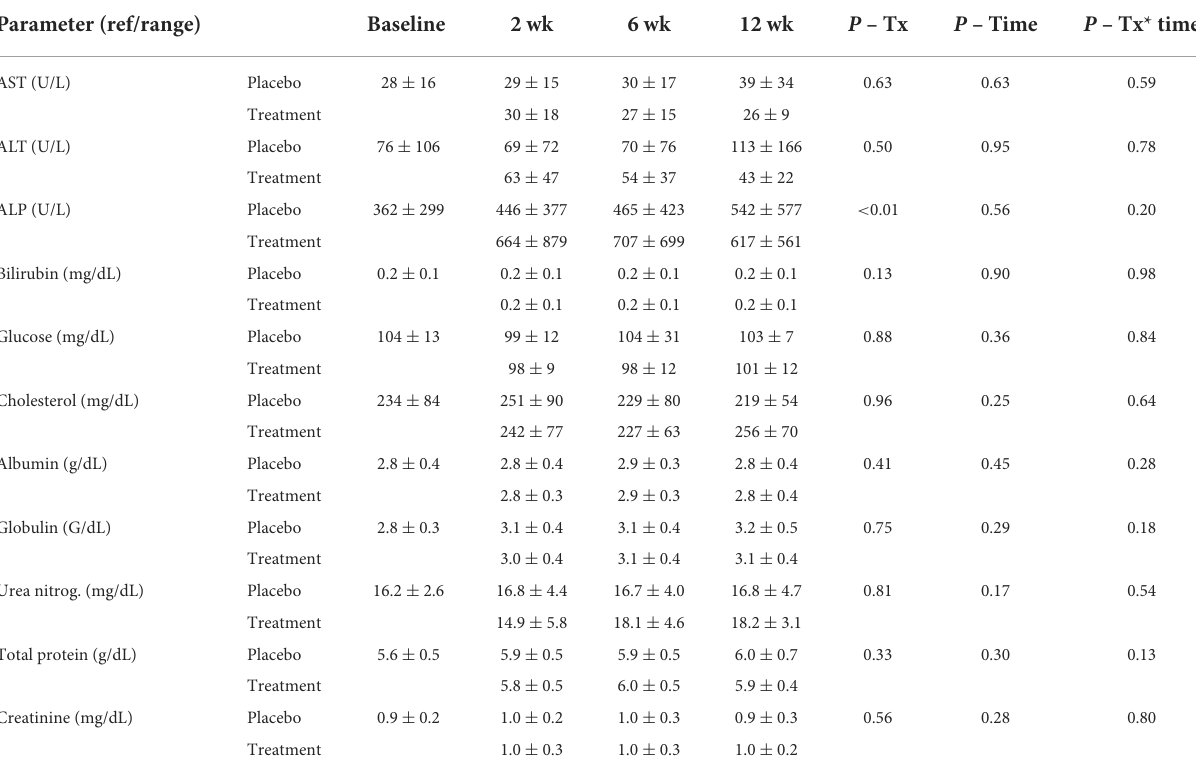
TABLE 2 Serum chemistry hepatic and renal parameter means and standard deviations at baseline, 2, 6, and 12 weeks of CBD/CBDA-rich hemp oil vs. placebo treatment ( n = 14) in a randomized cross over clinical trial. Parameter (ref/range)